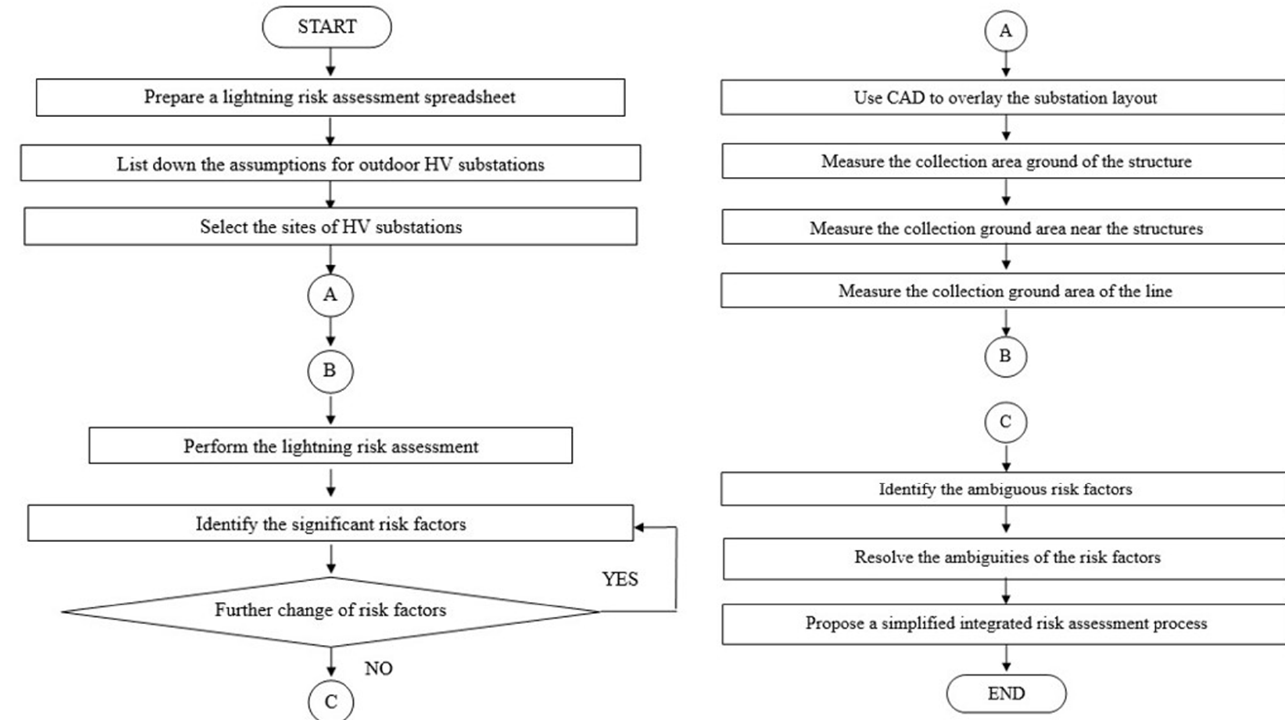
Figure 1. Process Flow of Lightning Risk Assessment.